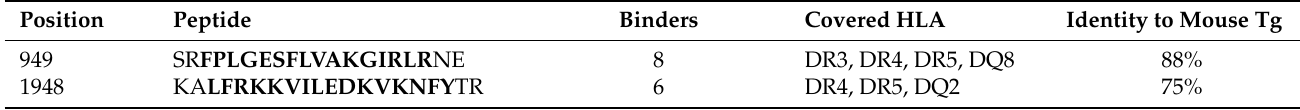
Table 1. Human Tg peptide fragments selected in the present study. The predicted binding cores are given in bold.